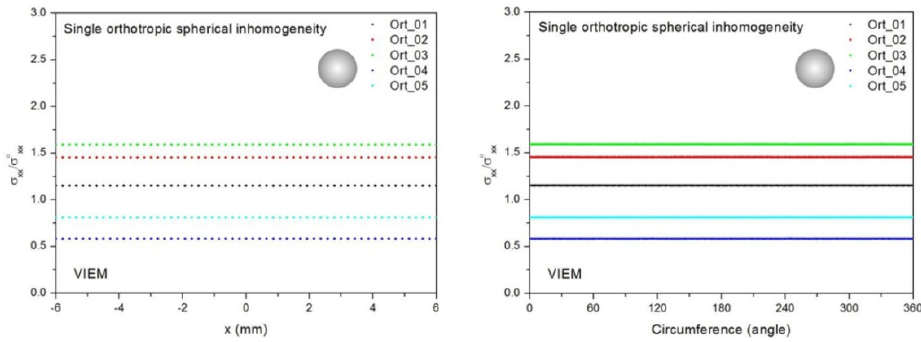
Figure 9. VIEM results for the normalized tensile stress component ( σ xx / σ oxx ) along ( left ) the x–axis inside and ( right ) the circumferential direction of the orthotropic spherical inclusions (Ort_01, Ort_02, Ort_03, Ort_04 and Ort_05) with a radius of 6 mm under uniform remote tensile loading. Table 9. Normalized tensile stress component ( σ xx / σ oxx ) within the orthotropic spherical inclusion due to uniform remote tensile loading ( σ oxx ).